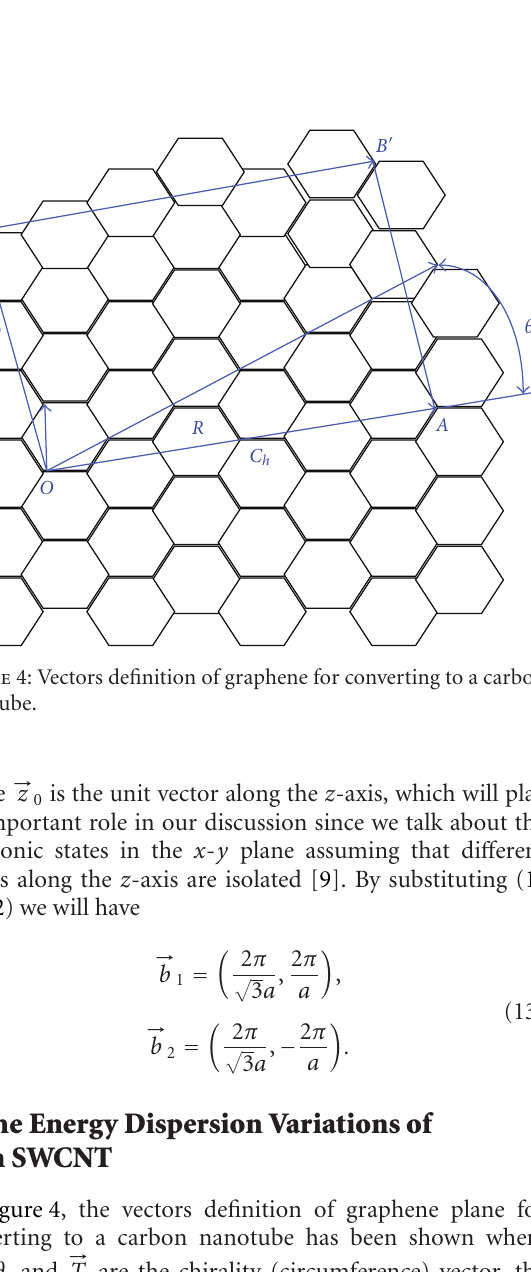
Figure 2: The energy dispersion variations of graphene lattice.